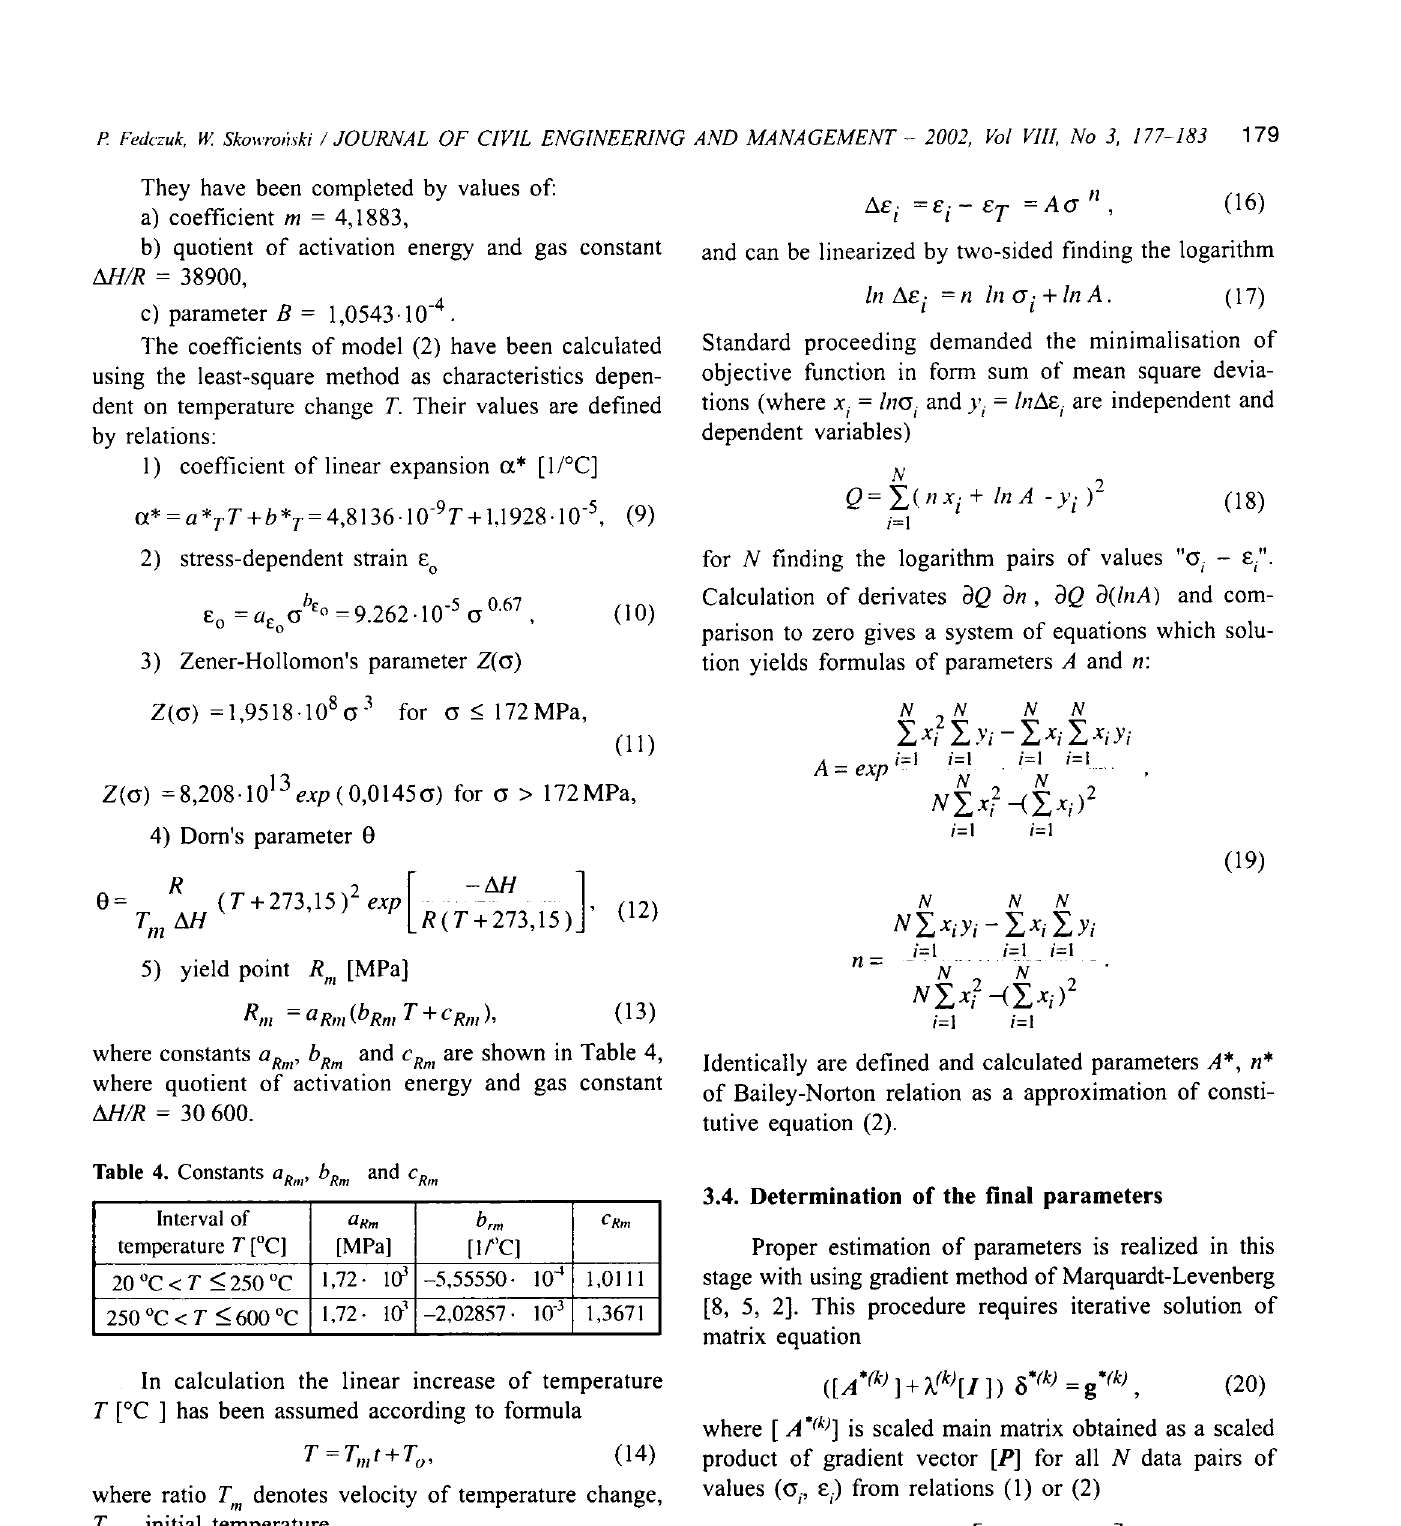
Table 4. Constants aRm' bRm and cRm Interval of